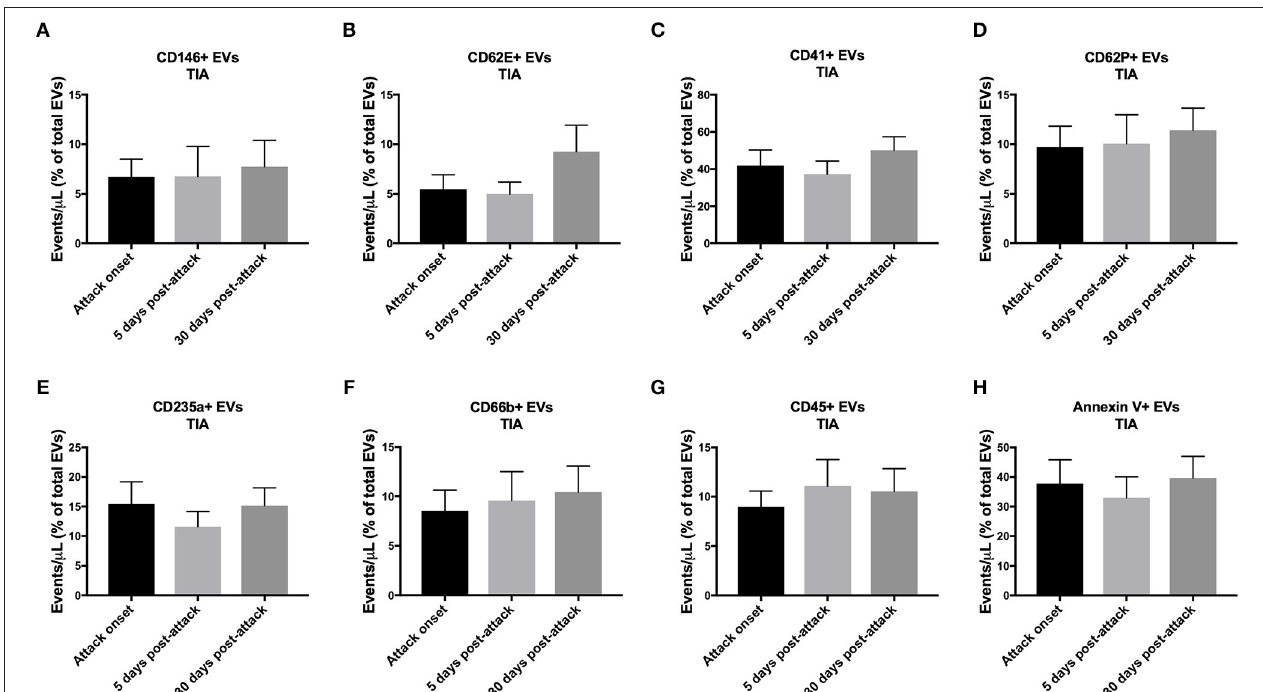
FIGURE 6 | Circulating EV levels, expressed as events/ µ L (% of total EVs), at onset, 5-days and 30-days post-attacks in PFP from patients with TIA. Histograms represent circulating levels of EVs derived from: (A) endothelial cells (CD146 + ), (B) activated endothelial cells (CD62E + ), (C) platelets (CD41), (D) activated platelets (CD62P + ), (E) erythrocytes (CD235a + ), (F) granulocytes (CD66b + ), (G) leukocytes (CD45 + ), (H) and pro-coagulant (Annexin V + ) origins. Data are expressed as mean ± SEM. TIA, n =